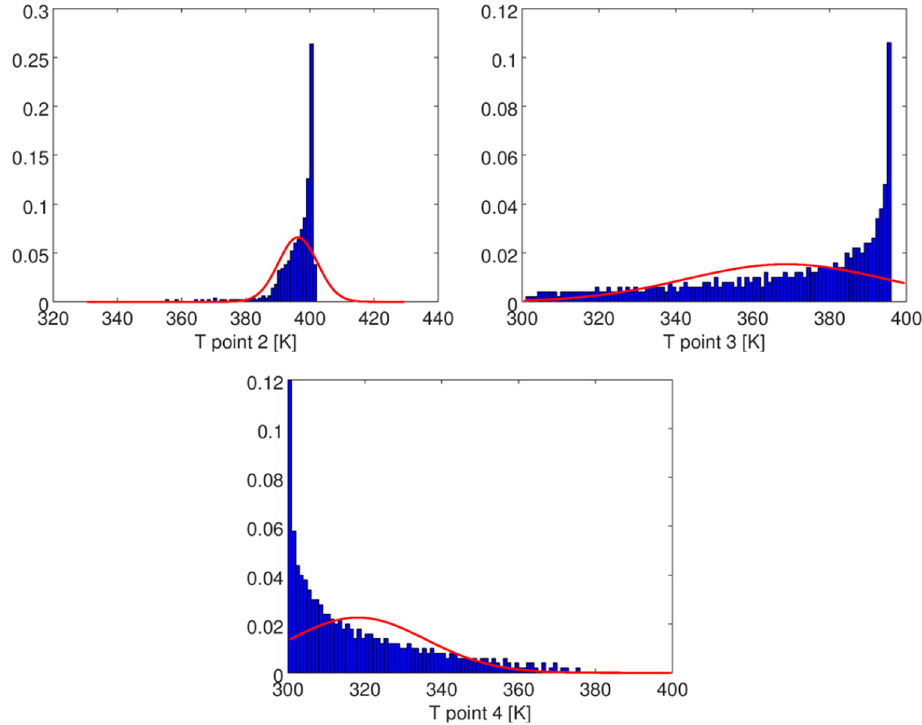
Figure 17. Pdf on control point temperature with normal input distribution of vf. Table 2. Main statistical moments for the output probability density function